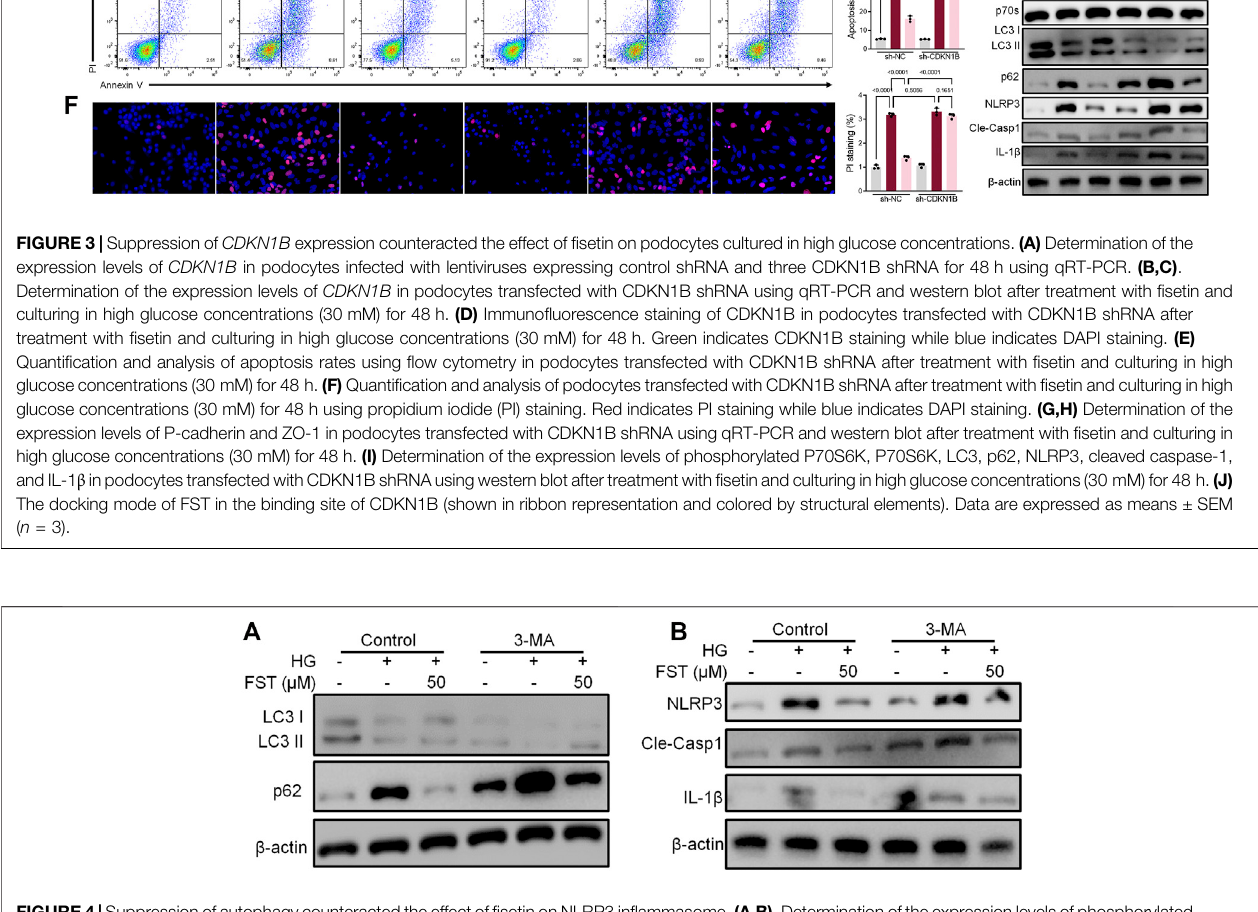
FIGURE4| Suppressionofautophagycounteractedtheeffectof fi setinonNLRP3in fl ammasome. (A,B) .Determinationoftheexpressionlevelsofphosphorylated P70S6K, P70S6K, LC3, p62, NLRP3, cleaved caspase-1, and IL-1 β in podocytes using western blot after treatment with fi setin and 3-MA (5 mM), and culturing in high glucose concentrations (30 mM) for 48